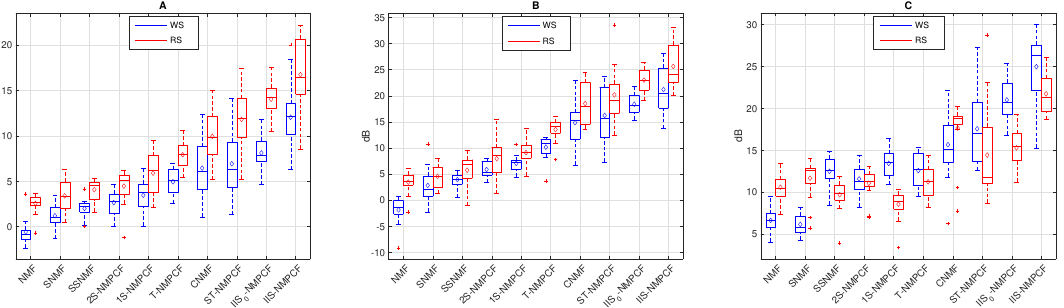
Figure 9. SDR w and SDR r results ( A ), SIR w and SIR r results ( B ) and SAR w and SAR r results ( C ) evaluating the dataset T1L (SNR = − 5 dB). Note that SDR w , SIR w and SAR w are represented by blue boxes while SDR r , SIR r and SAR r are represented by red